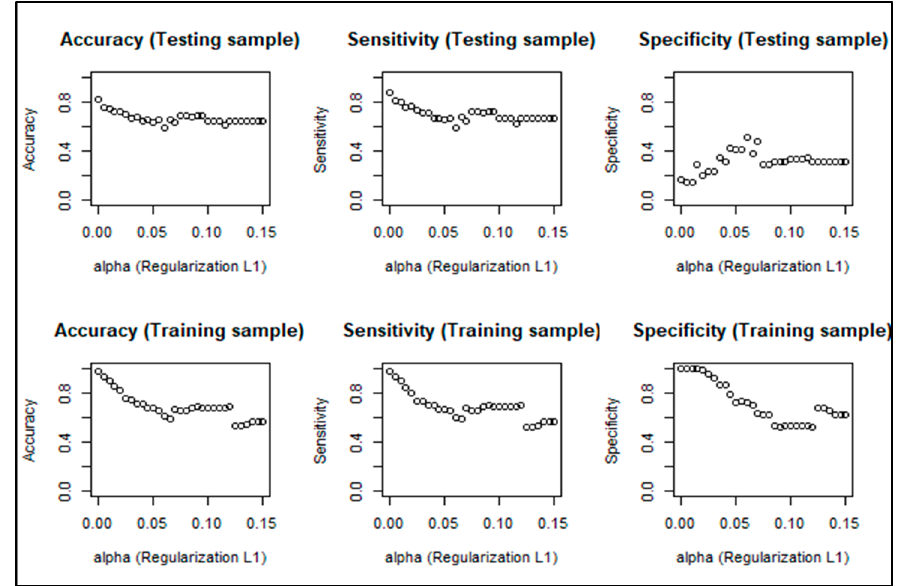
Figure 3. The predictive measures according to α . L1 method applied to the training and testing samples.